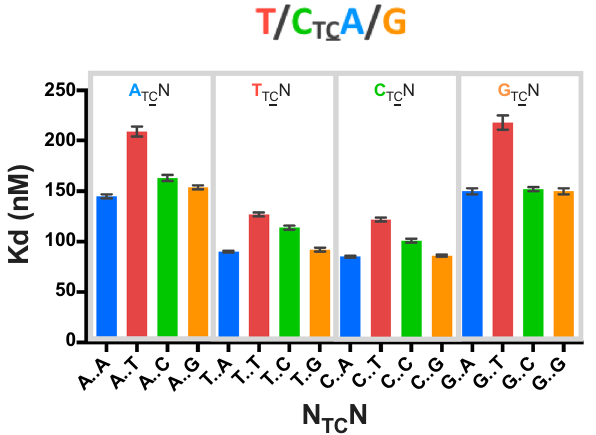
Figure 3. A3A specificity for poly A NTCN. Binding affinity of A3A(E72A) to TAMRA-labeled ssDNA sequences in a Poly A background. Gray boxes bin sequences by − 2 nucleotide identity. Colors represent + 1 nucleotide identity: A (blue), T (red), C (green), G (orange). Consensus sequence derived from these K d values is shown above the